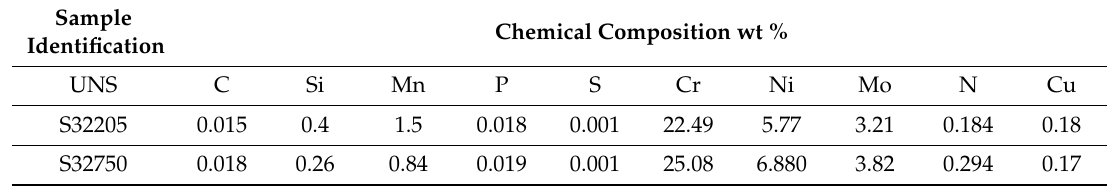
Table 1. Chemical composition of duplex and super duplex stainless